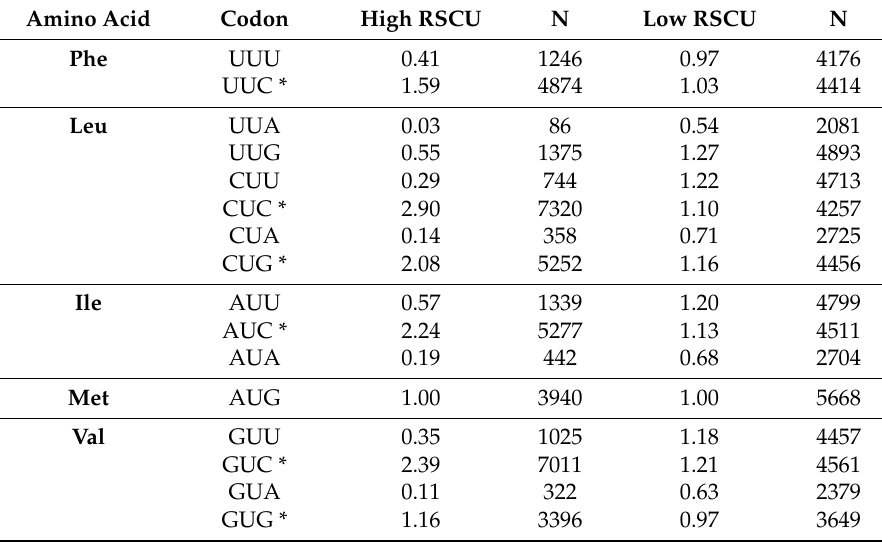
Table 5. Optimal codons of genes in E.